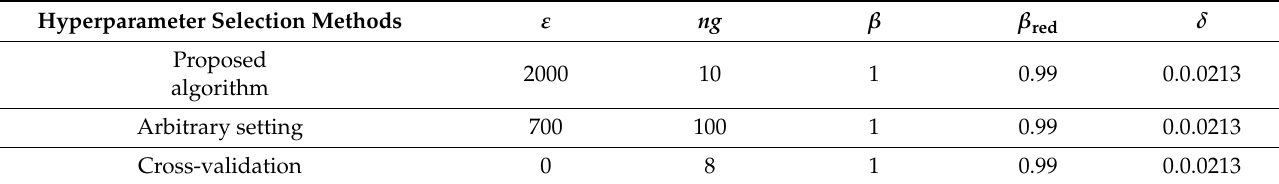
Table 2. Different sets of hyperparameters used to compare the performance of the proposed algorithm. Hyperparameter Selection